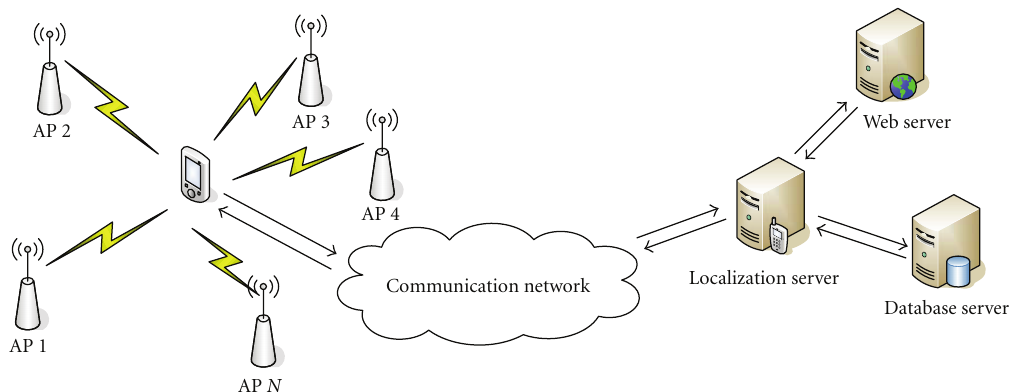
Figure 5: Architecture of the WifiLOC positioning system.